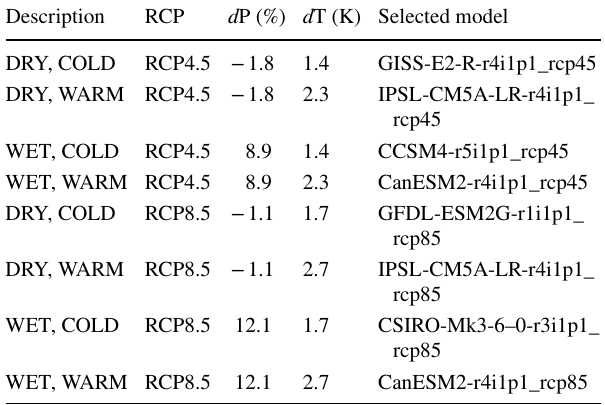
Table 3 Result of the statistical analysis to determine the design year